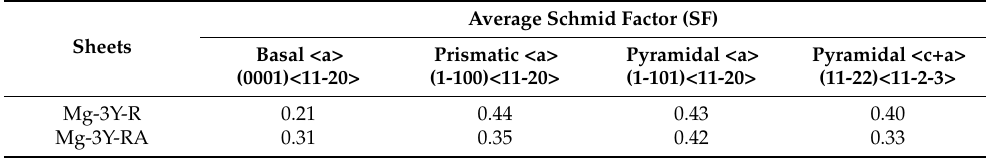
Table 2. Average Schmid factor (SF) of slip systems in Mg-3Y